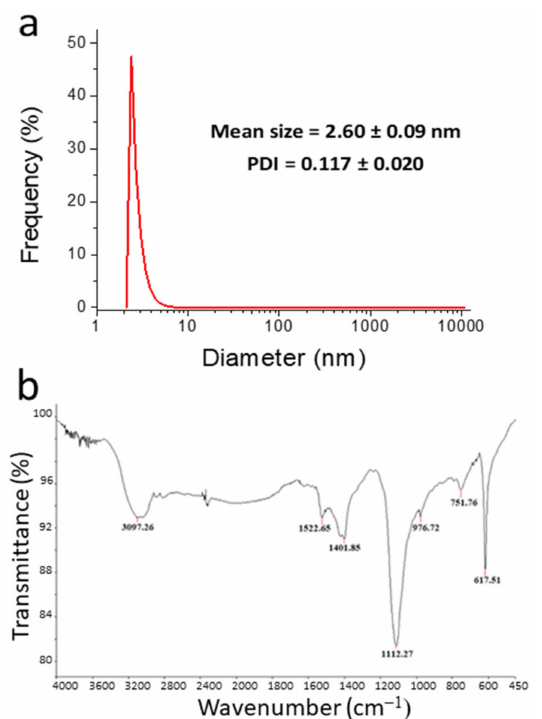
Figure 2. ( a ) DLS measurement and ( b ) FTIR spectrum of